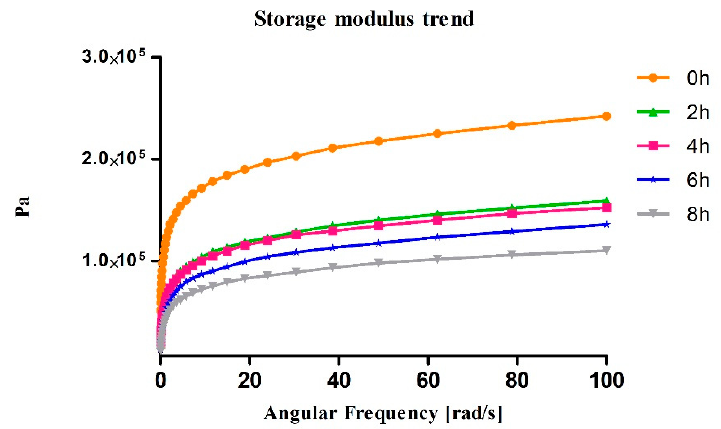
Figure 2. Storage modulus trends obtained through the rheology assay in fermented doughs.